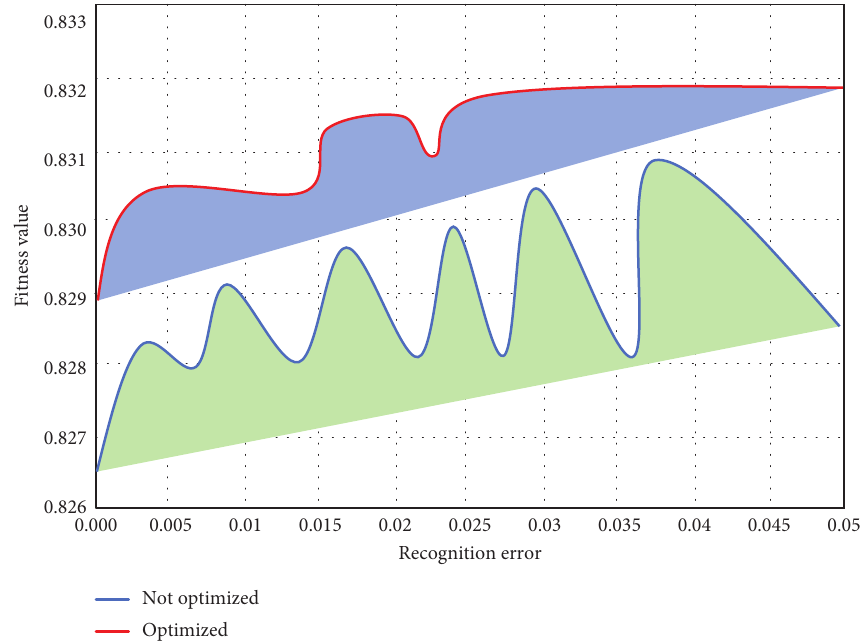
Figure 5: Simulation results of the wind instrument feature extraction model.